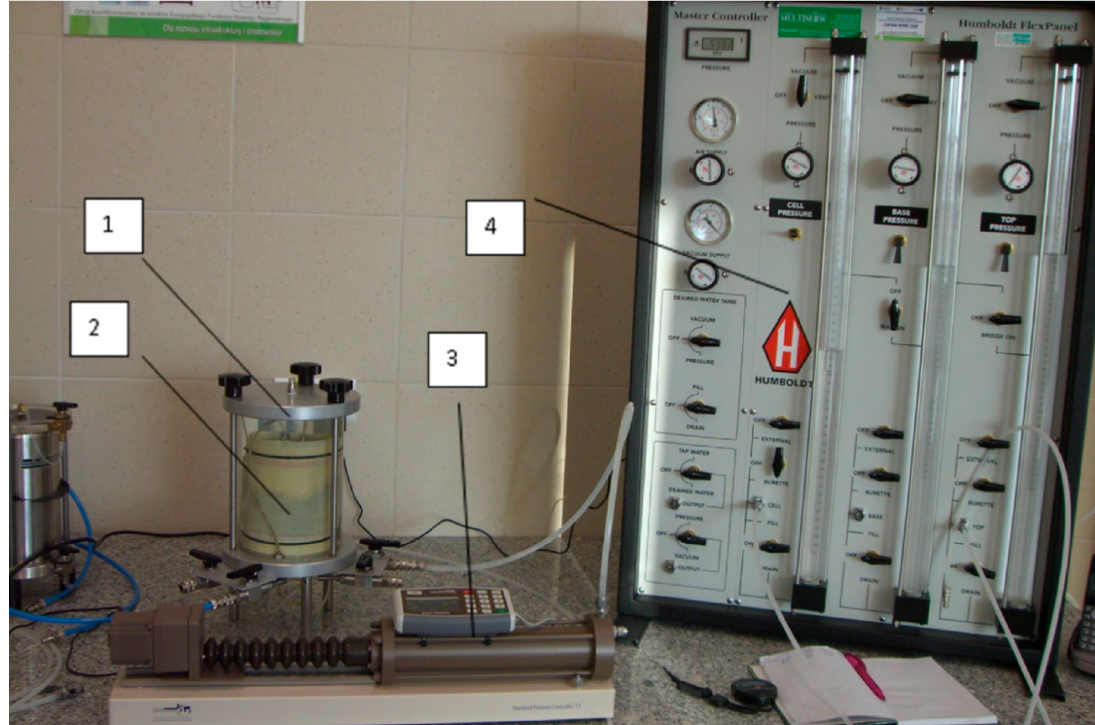
Figure 2. Photos of the permeability apparatus: ( 1 ) Testing cell; ( 2 ) specimen; ( 3 ) volume/pressure controller; ( 4 ) cell pressure controller.